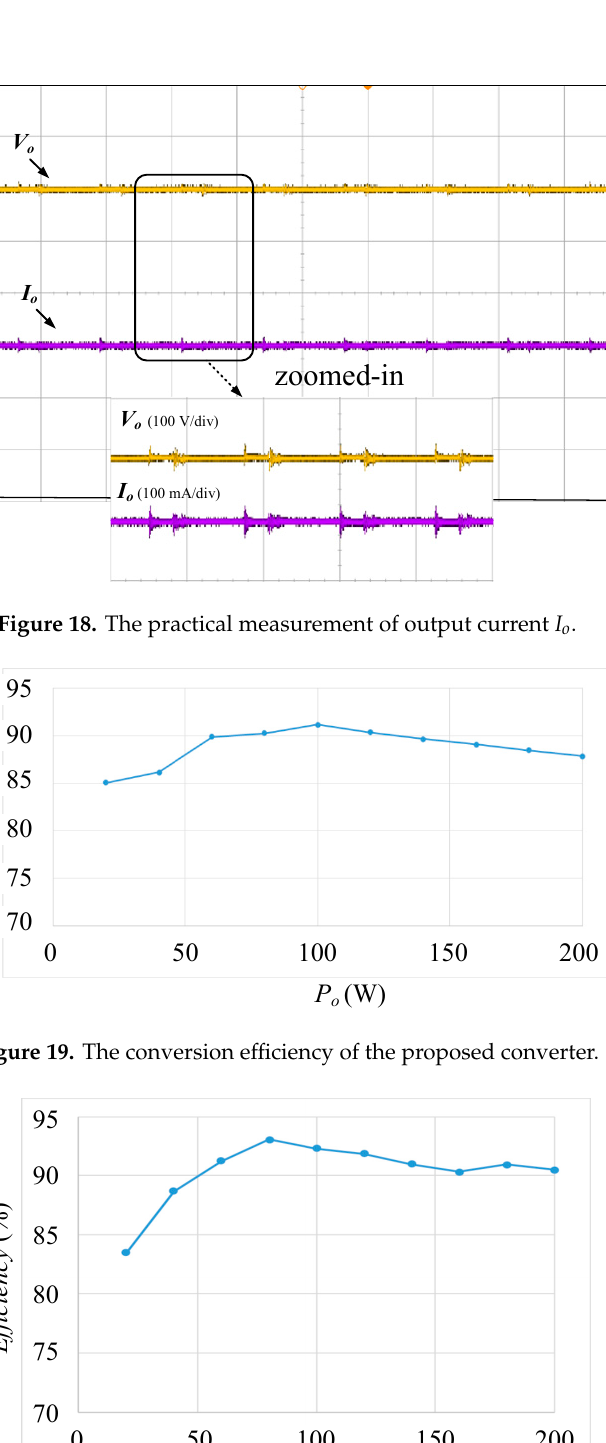
Figure 21. Photo of the prototype. 5. Conclusions In this paper, a dual-input converter is proposed, which possesses the characteristics of ultra- high voltage gain, continuous input currents, galvanic isolation, inherent voltage-clamp feature, and recycling the energy stored in leakage inductance. This converter is capable of controlling the dual inputs independently and individually. Moreover, it still can accomplish all the mentioned features even under the case that either input encounters power failure. That is, the converter has operation flexibility to operate at dual-input situation or single-input situation for accommodating input conditions. A maximum of measured efficient is about 91.4% at dual-input operation. Author Contributions: Conceptualization, C.-L.S., L.-Z.C. and H.-Y.C.; writing-original draft preparation, C.- L.S. and L.-Z.C.; writing-review and editing, C.-L.S. and L.-Z.C.; methodology, C.-L.S., L.-Z.C. and H.-Y.C.; validation, C.-L.S. and L.-Z.C.; supervision, C.-L.S. Funding: This research received no external funding. Conflicts of Interest: The authors declare no conflict of interest. References 1.